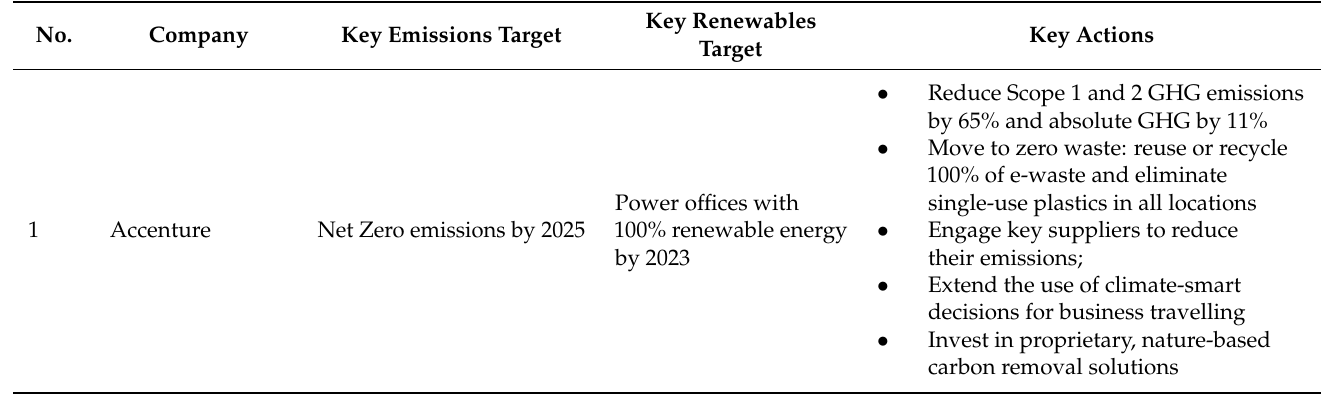
Table 3. Companies’ emissions and renewable energy targets.